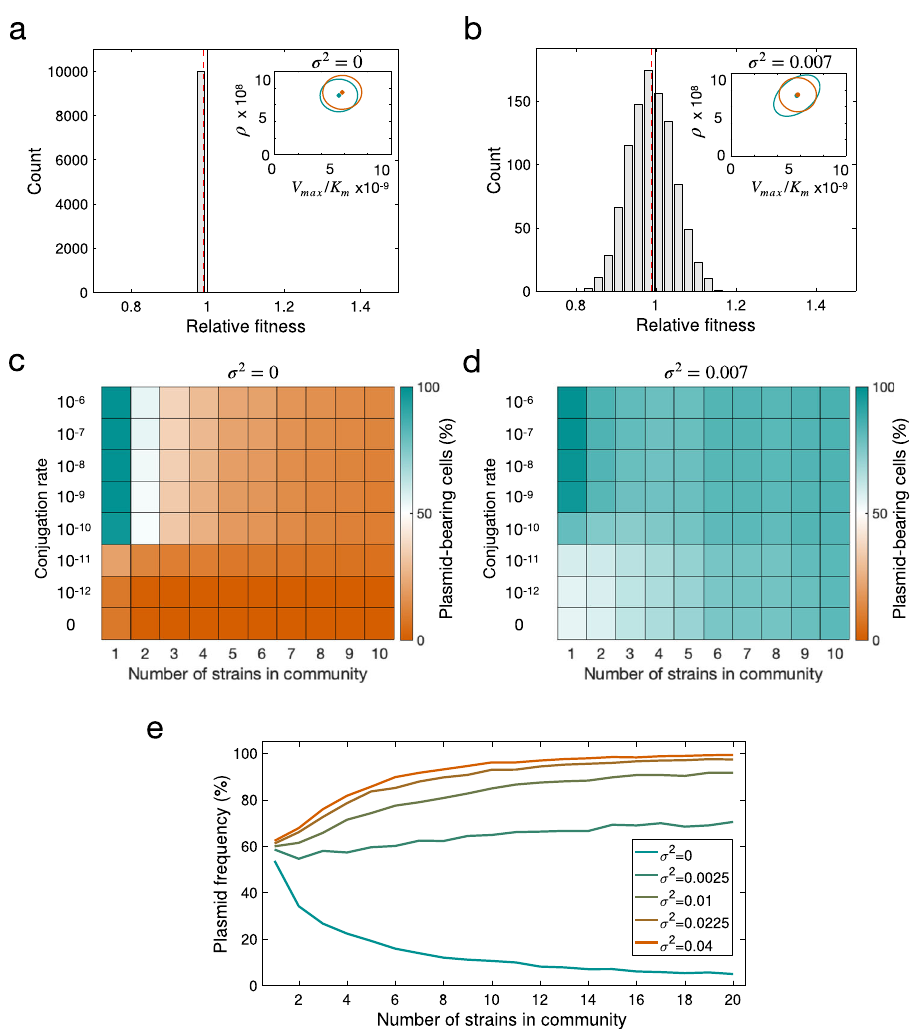
Fig. 6 Plasmid peristence in complex communities. Modelling plasmid persistence in polymicrobial communities, assuming fi xed ( a , c ) or variable ( b , d ) plasmid fi tness effects. a , b Relative fi tness histogram obtained by randomly sampling 10 4 parameter values from the parameter distribution shown in the inset plot (points illustrate the expected values of each distribution and ellipses their standard deviation; green, plasmid-bearing bacteria; orange, plasmid-free bacteria). The green ellipse in b is larger as a consequence of considering that the cost of plasmid-bearing is normally distributed with variance ( σ 2 = 0.007). As a result, the distribution of plasmid fi tness effects also has higher variance, with a considerable fraction of plasmid – host associations producing a bene fi t to the host. Dotted red lines indicate mean relative fi tness of plasmid carrying cells. c , d Colour gradient represents the percentage of cells carrying plasmids at the end of 5000 stochastic simulations; orange indicates a population without plasmids and green a community composed of plasmid-carrying cells. If plasmid-bearing is associated with a fi xed fi tness cost for all members of the community, plasmid maintenance requires a high conjugation rate. The increased proportion of plasmid-bearing cells in d indicates that a distribution of plasmid fi tness effects with high variance reduces the critical conjugation rate needed to maintain plasmids in the population, enabling plasmids to persist at low conjugation rates. e Mean fraction of plasmid-bearing cells as a function of the number of strains in the community with a conjugation rate γ = 1.5 × 10 − 11 . If the plasmid always produces a reduction in host fi tness (mean w < 1 and low variance), plasmid frequency decreases as the number of strains in the community increases (green line). In contrast, for higher variance at the same mean w , the fraction of plasmid-bearing cells increases with community complexity (orange